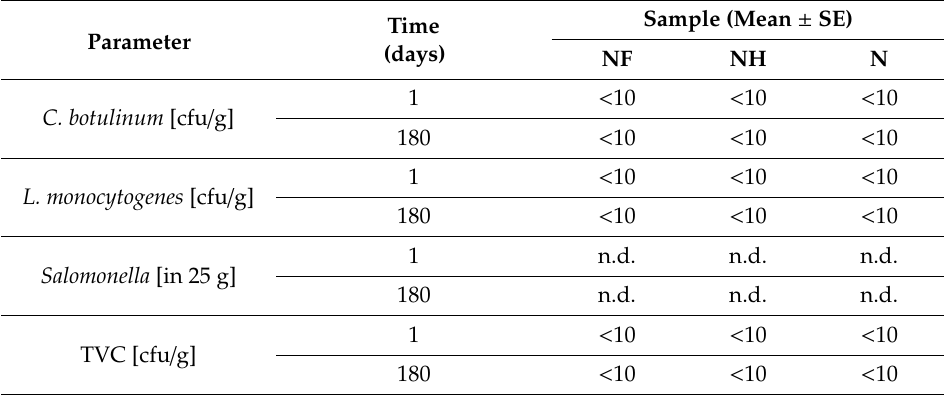
Table 6. Microbiological analysis of canned pork with reduced amount of nitrite during storage. Parameter